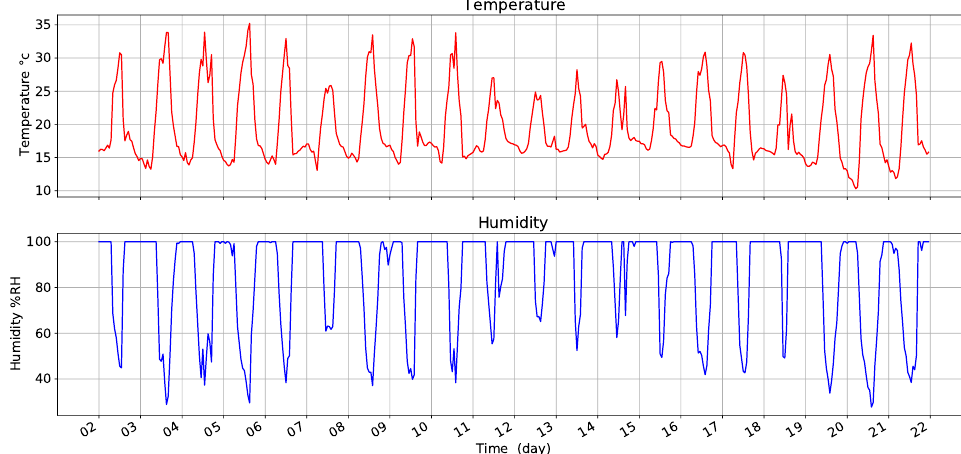
Figure 10. Temperature and humidity at Coffee farm.